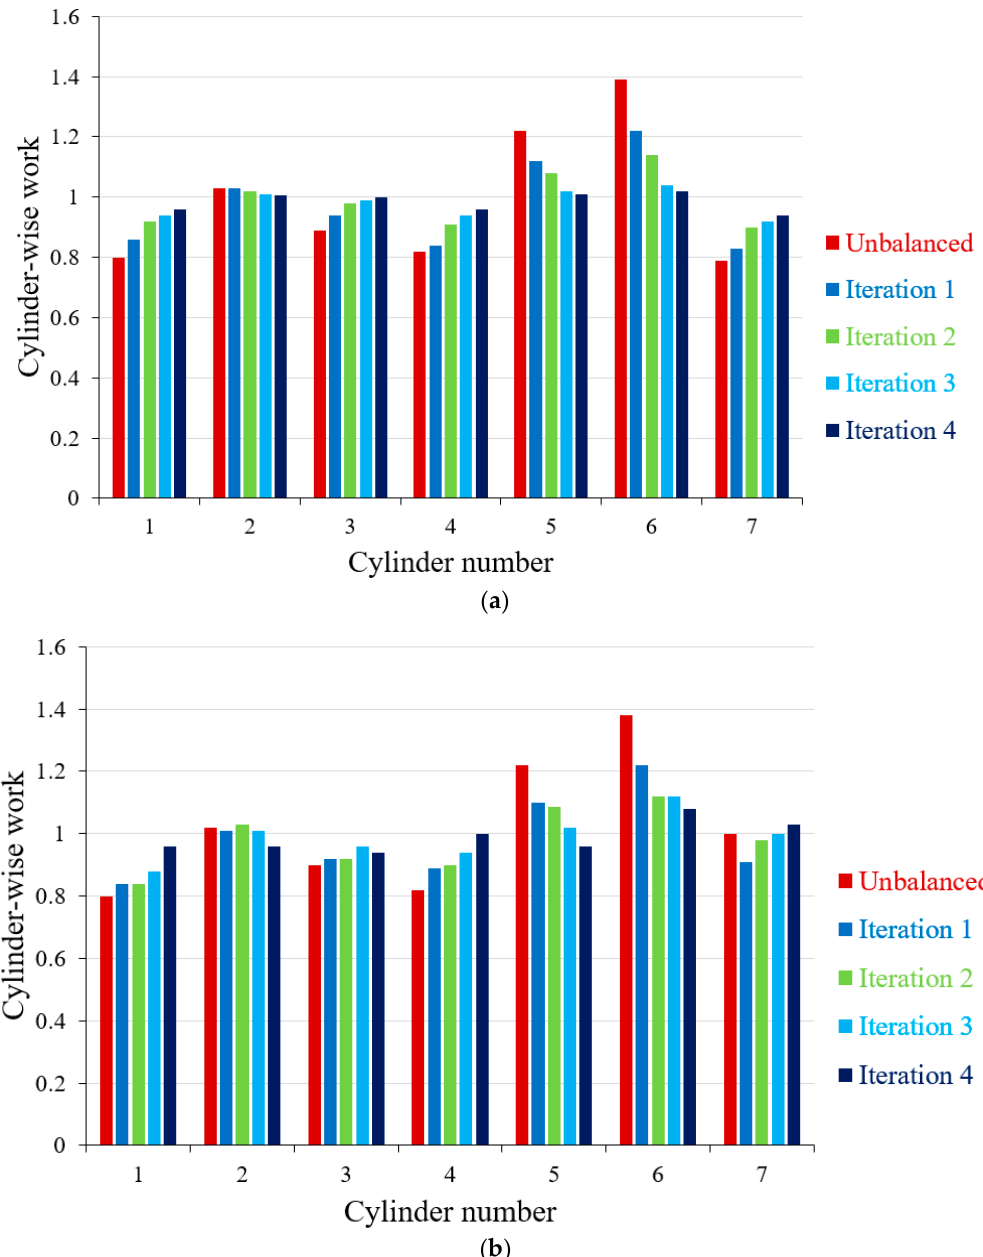
Figure 1. Normalized cylinder-wise torque integrals in power balancing results: ( a ) simulations; ( b ) actual test on a medium-speed 7-cylinder diesel engine [9].